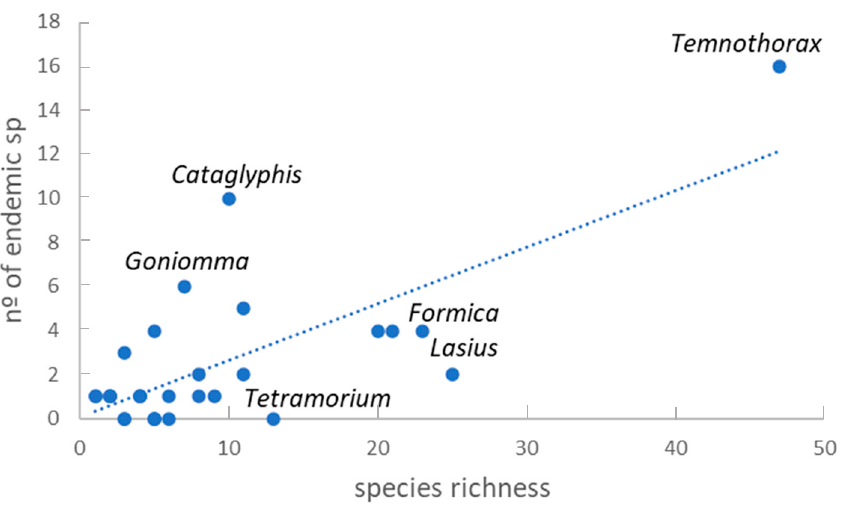
Figure 3. Positive correlation between species richness and the number of endemic species in each genera, including only native species (R = 0.73; p < 0.0001; F (1,28) = 33.32). Table 2. Total shared and unshared species and percentage amongst France (Fr), Iberian Peninsula (IP) and Morocco (Mo).